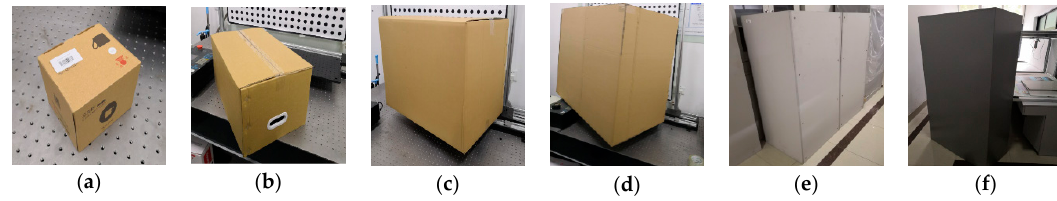
Figure 25. Six standard boxes with different dimension parameters: ( a ) 143.4 × 120.5 × 100; ( b ) 550.6 × 350.5 × 300.0; ( c ) 800.0 × 600.0 × 500.0; ( d ) 1200.0 × 900.0 × 700.0; ( e ) 1500.0 × 690.7 × 570.5; and, ( f ) 1800.0 × 900.0 × 400.0. Table 5. Volume measurement results in real applications.